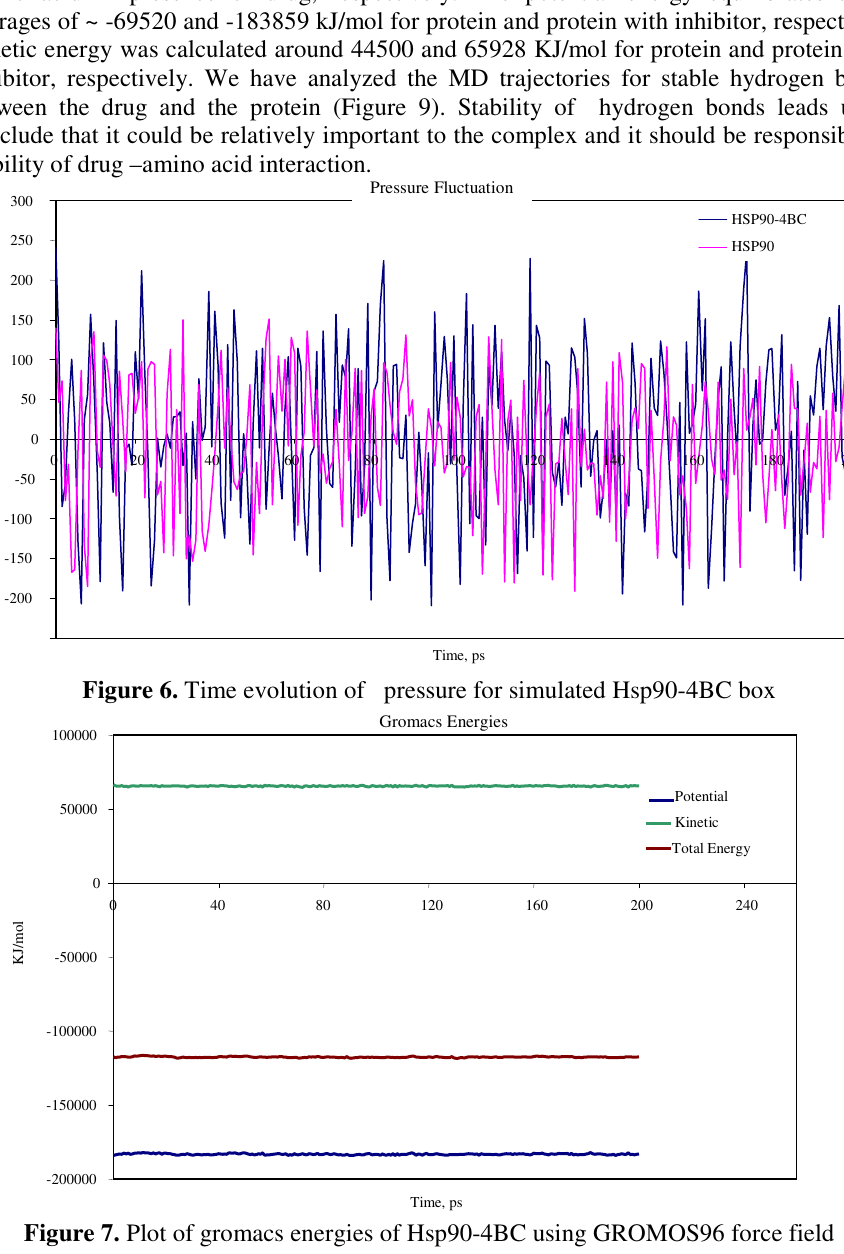
Figure 7. Plot of gromacs energies of Hsp90-4BC using GROMOS96 force